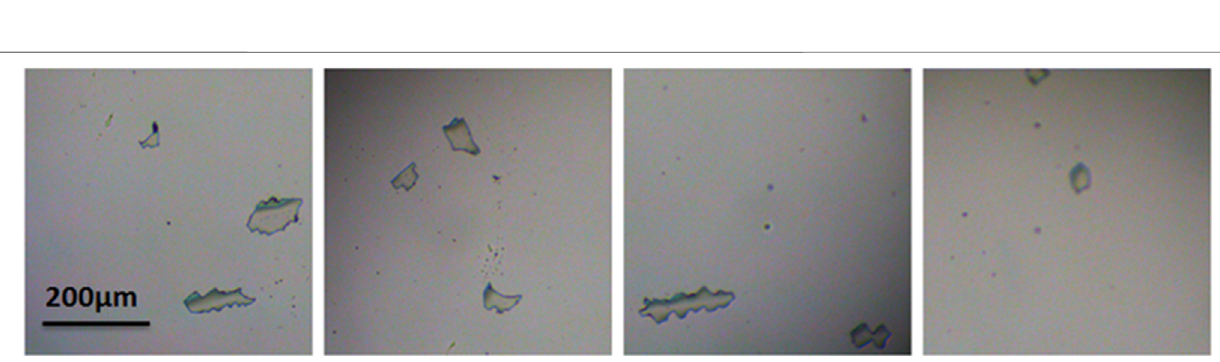
Frontiers in Materials |